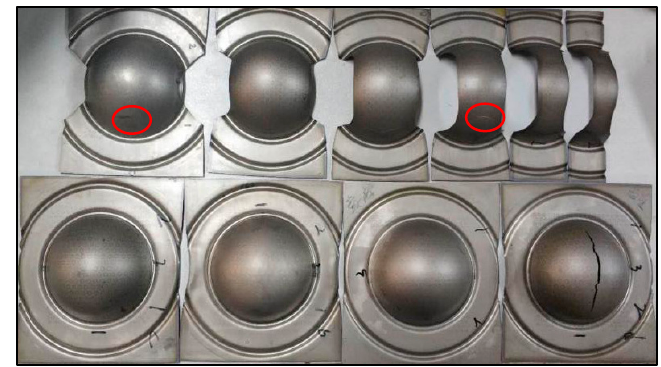
Figure 10. Hemispherical punch stretching tests for part of specimens.